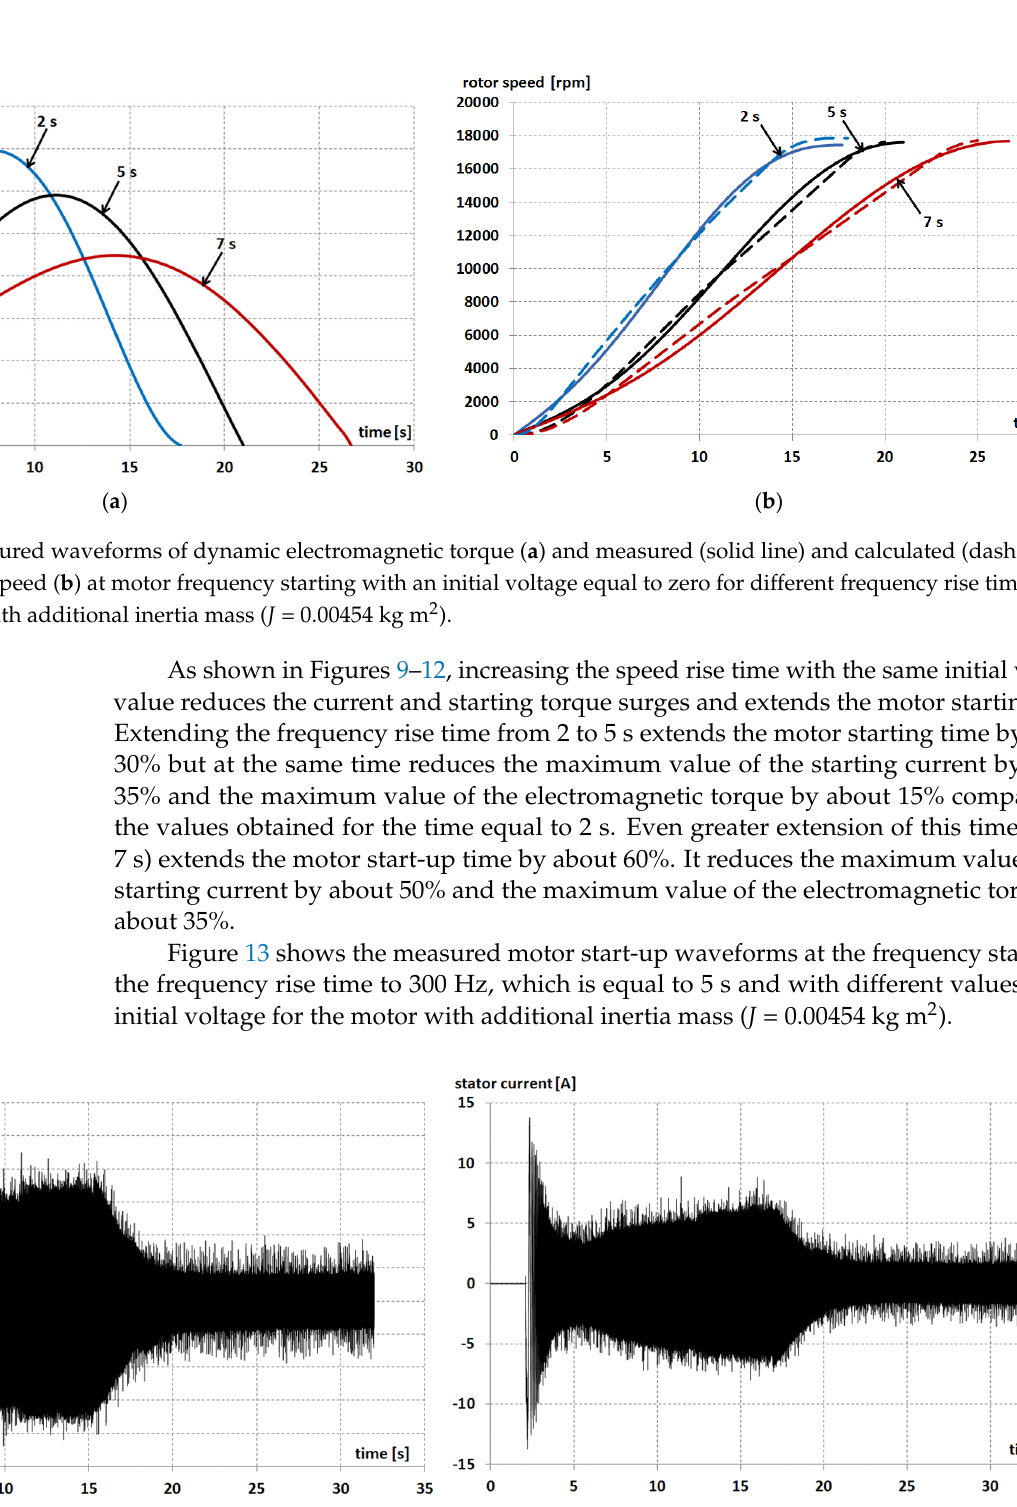
( b ) Figure 11. The measured waveforms of the instantaneous value of the current in the stator phase winding at the frequency